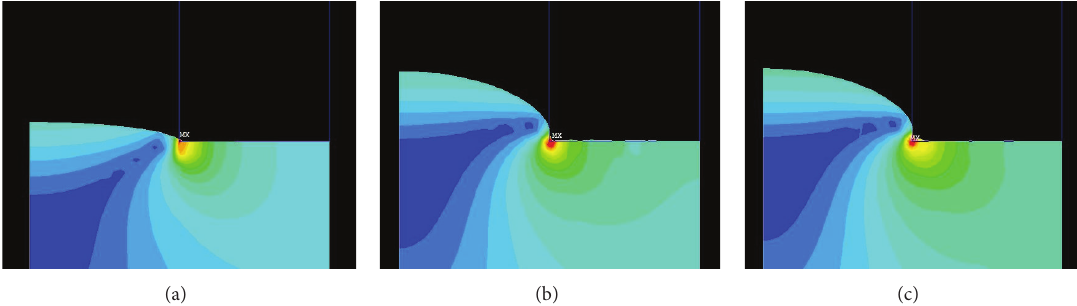
Figure 1: Process of forming a microlens using noncontact microembossing